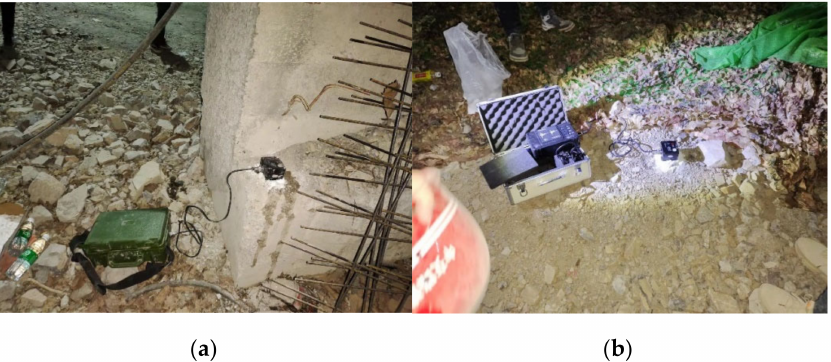
Figure 16. Site photos of vibration monitoring. ( a ) Monitoring point 1; ( b ) Monitoring point